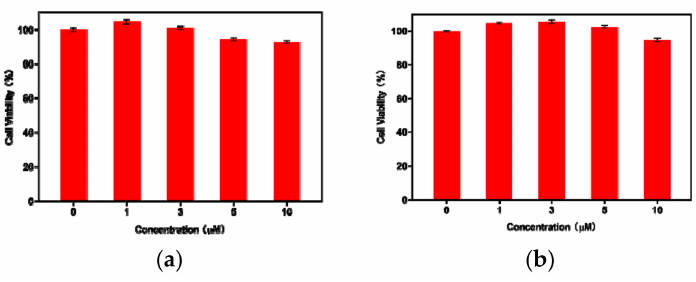
Figure 7. Cytotoxicity results of ( a ) AIE-1 and ( b ) AIE-2 on HeLa cells using concentrations from 0–10 µ M with 24 h incubation time.